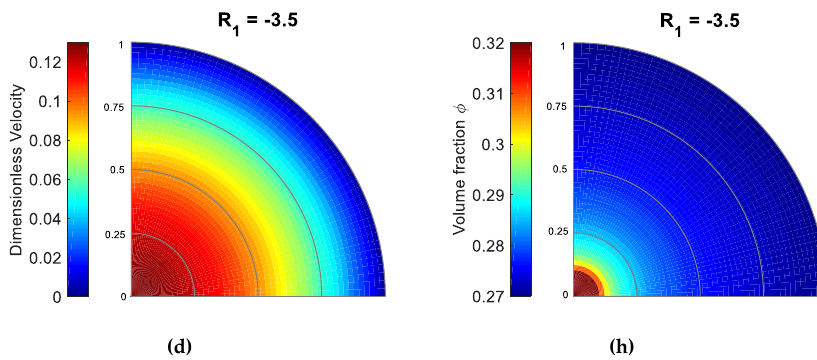
Figure 13. Distribution of the velocity for ( a ) R 1 = 0; ( b ) R 1 = − 1.5; ( c ) R 1 = − 2.5; ( d ) R 1 = − 3.5; and the cement volume concentration for ( e ) R 1 = 0; ( f ) R 1 = − 1.5; ( g ) R 1 = − 2.5; ( h ) R 1 = − 3.5.